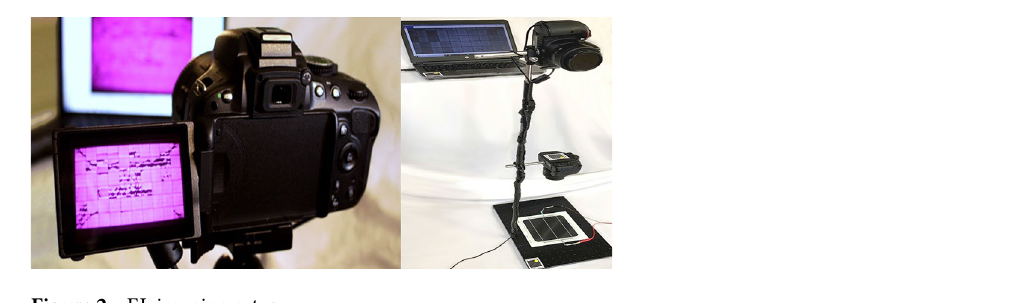
Figure 2. EL imaging